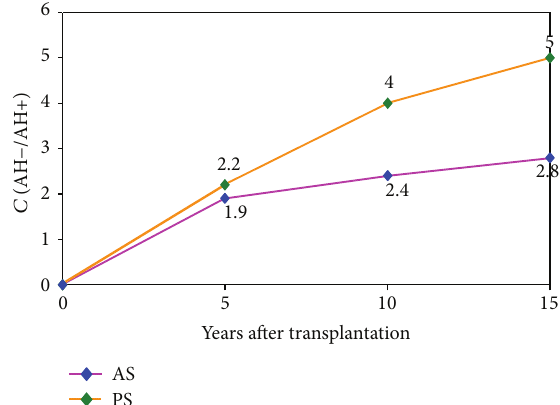
Figure 2: Correlation ( 𝐶 ) of long-term survivability of patients (PS) and allografts (AS) depending on absence or presence of arterial hypertension (AH −